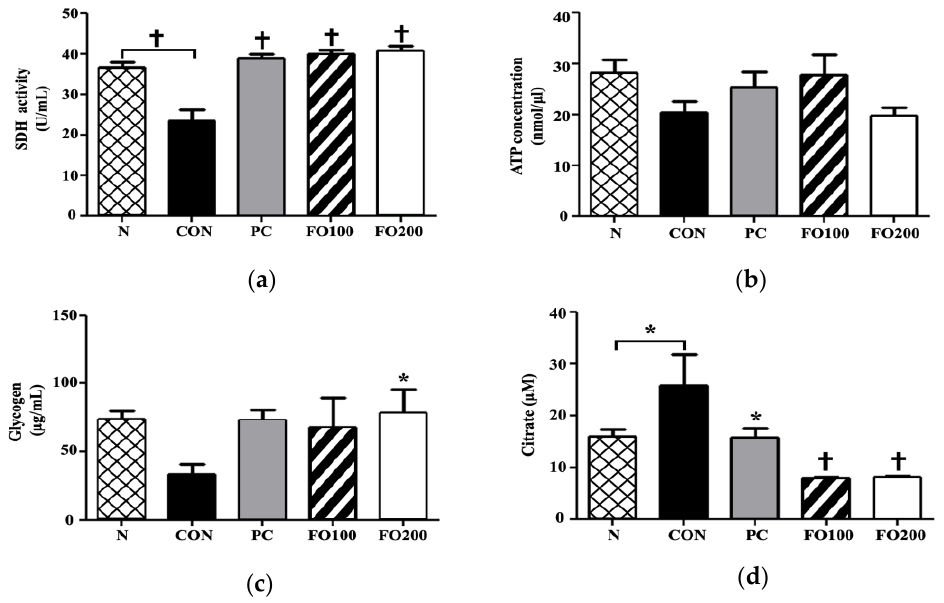
Figure 9. Changes in muscle ( a ) SDH, ( b ) ATP, ( c ) glycogen and ( d ) citrate were measured following administration of 100 and 200 μg/mL of FO. Each bar represents the mean ± SD. A one-way ANOVA